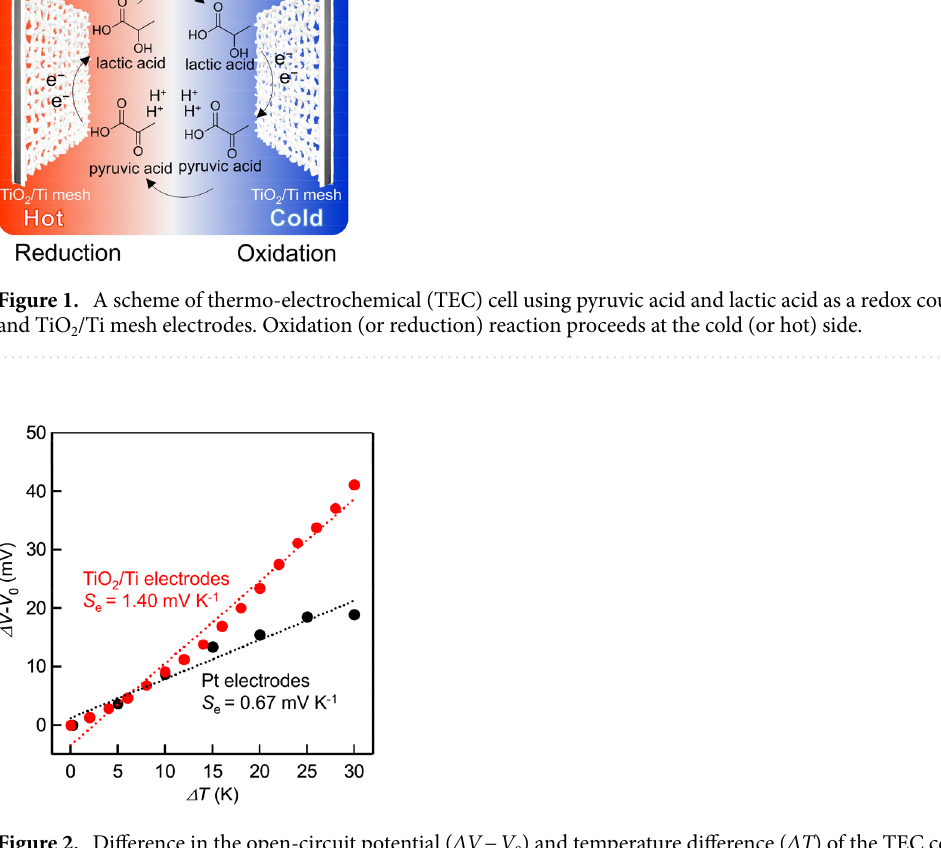
Figure 2. Difference in the open-circuit potential ( ΔV − V 0 ) and temperature difference ( ΔT ) of the TEC cell using TiO 2 /Ti mesh electrodes (red) and Pt wire electrodes (black). V 0 is the initial open-circuit potential differences, as shown in Table S2. The initial concentration of pyruvic acid, lactic acid, and sodium sulfate were 20, 20 and 50 mM, respectively. Seebeck coefficients were calculated by the least-square fitting of a dotted